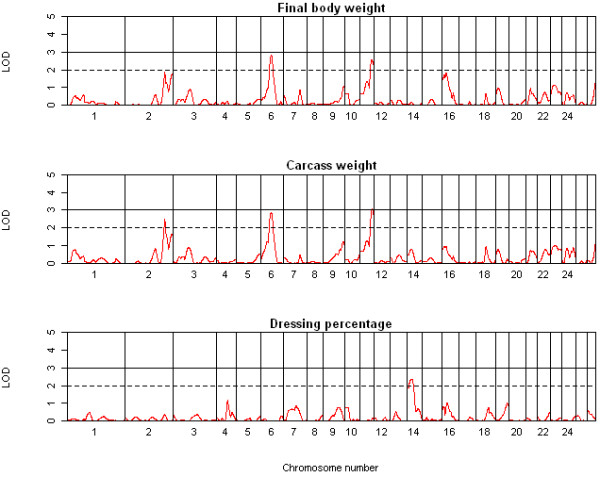
QTL map of the entire genome for body and carcass weight and dressing percentage.